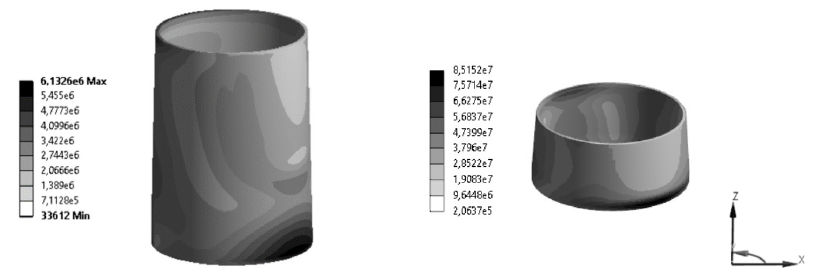
Figure 14. Stress state (von Mises, Pa) for both connection angles: ( a ) 1.25 ◦ ; and ( b ) 3.75 ◦ .